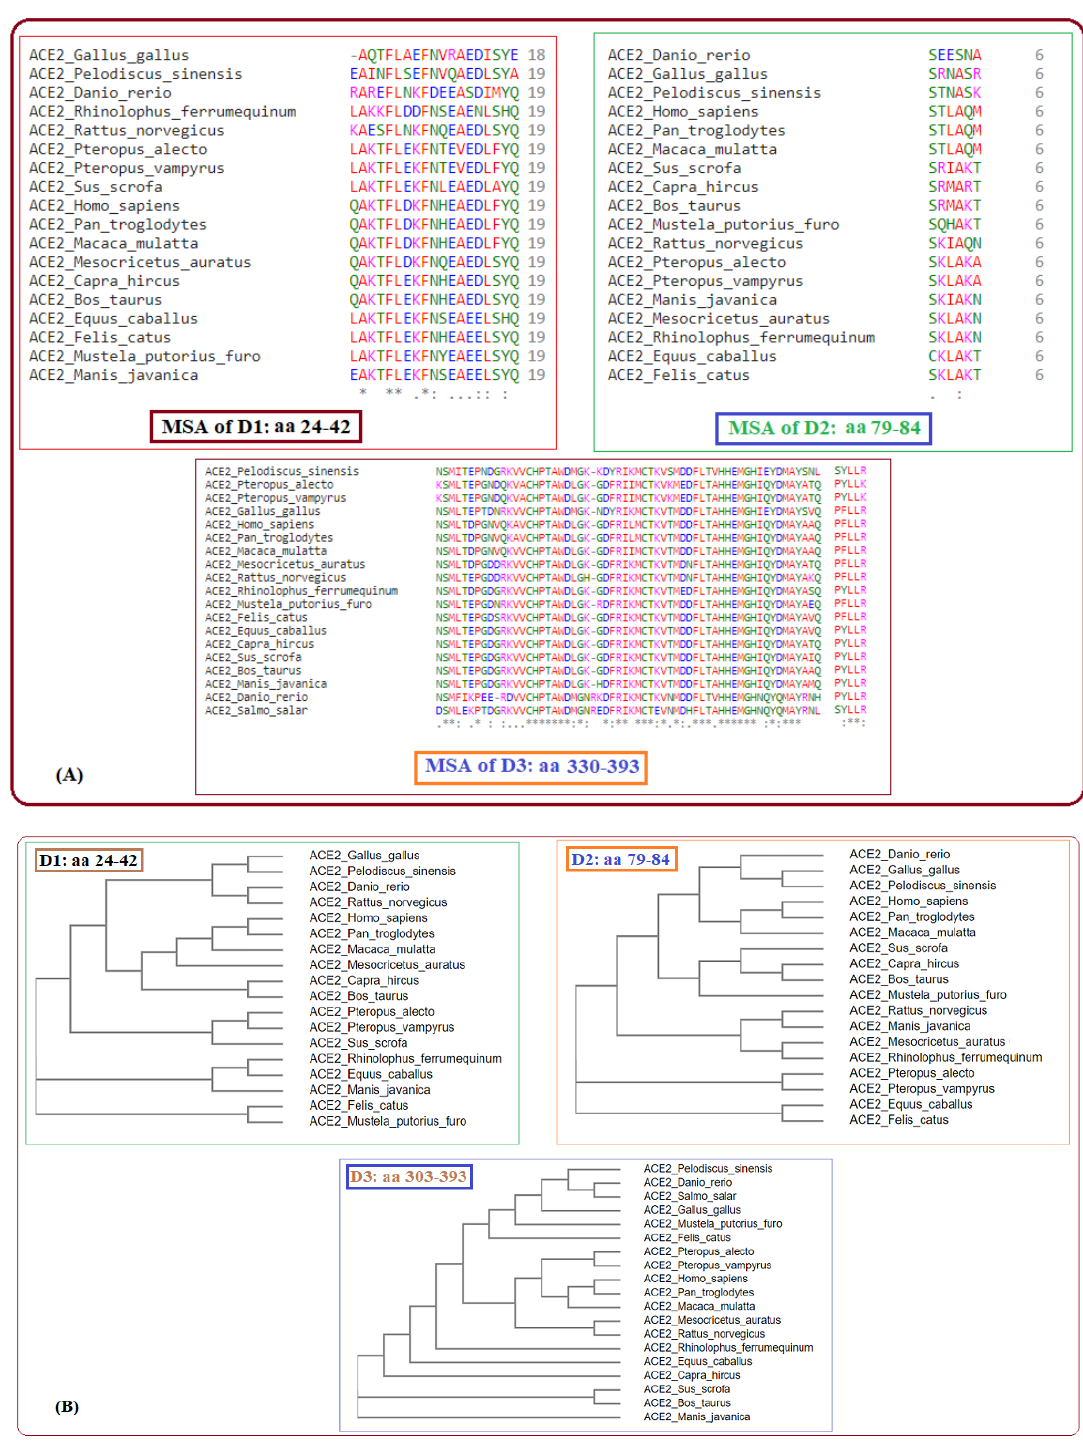
Figure 2. Multiple sequence alignments of D1, D2, and D3 domains of ACE2 of nineteen species ( A ) and respective phylogenies ( B